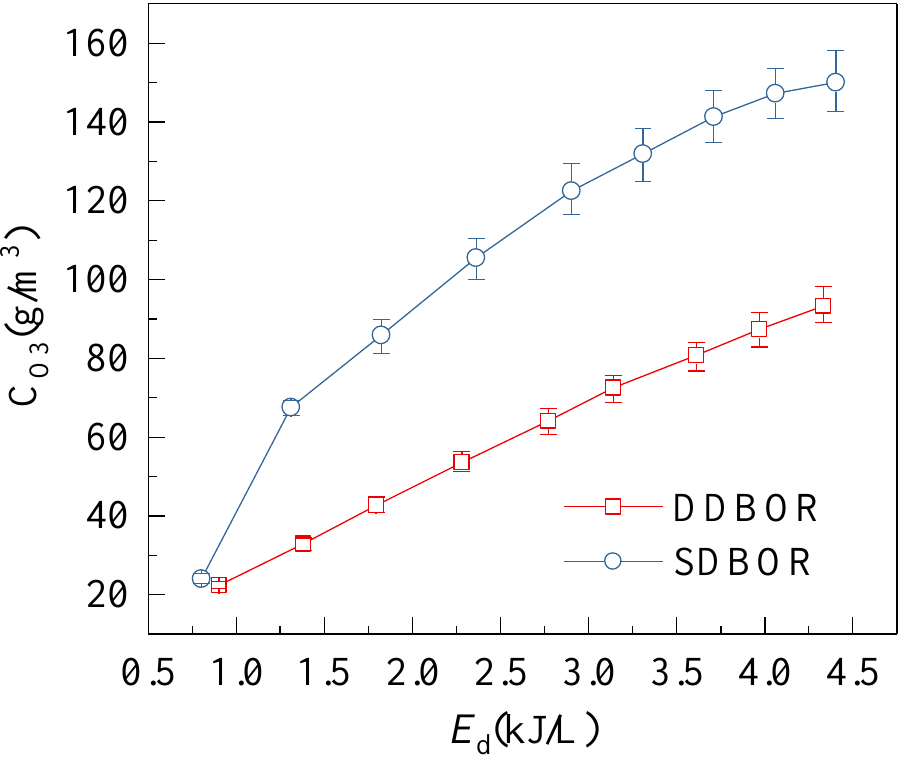
Figure 8. Dependence of ozone concentration on energy density (discharge gap = 0.5 mm, gas flow rate =3 L/min).